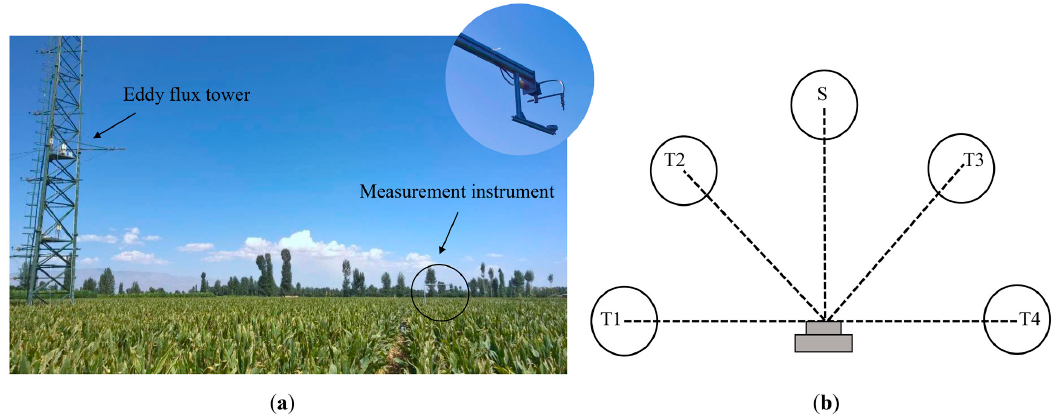
Figure 2. Overview of the spectral measurements: ( a ) spectral measurement system; and ( b ) positions of the standard reflectance panels (S) and the four canopy targets (T1–T4).